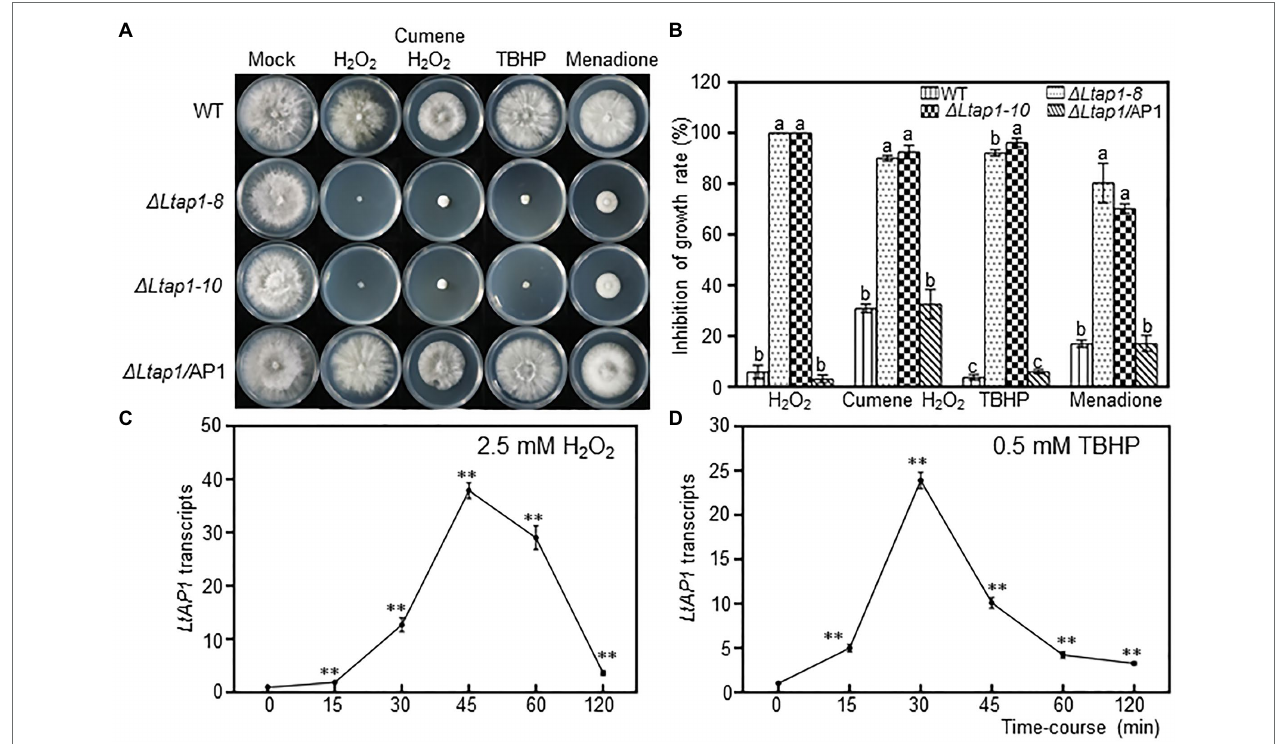
FIGURE 3 | Defects of LtAP1 on the response of L. theobromae to oxidative stress. (A) Mycelial growth of WT, two deletion strains and the complementary strain Δ Ltap1/ AP1, cultured on PDA media amended with oxidants 2.5 mm H 2 O 2 , 0.68 mm cumene H 2 O 2 , 0.5 mm tert -butyl-hydroperoxide (TBHP), and 0.1 mm menadione or water (mock) at the indicated concentrations after 36 h. (B) Inhibition rate of fungal growth on PDA with oxidants compared with PDA without stress exposure. Different letters on top of bars represent a statistically significant differences at p < 0.05. Bars show mean inhibition of growth rate averaged across three biological replicates, and error bars represent standard deviation. (C,D) Time-course response of LtAP1 transcripts to H 2 O 2 or TBHP exposure. Transcript levels were normalized with reference gene LtTUB and are displayed relative to the transcript level in samples at time zero (which was therefore set to one). Asterisks indicate the significant difference relative to the initial point (0 min) at p < 0.01. Values are means ± SD of three biological and three technical